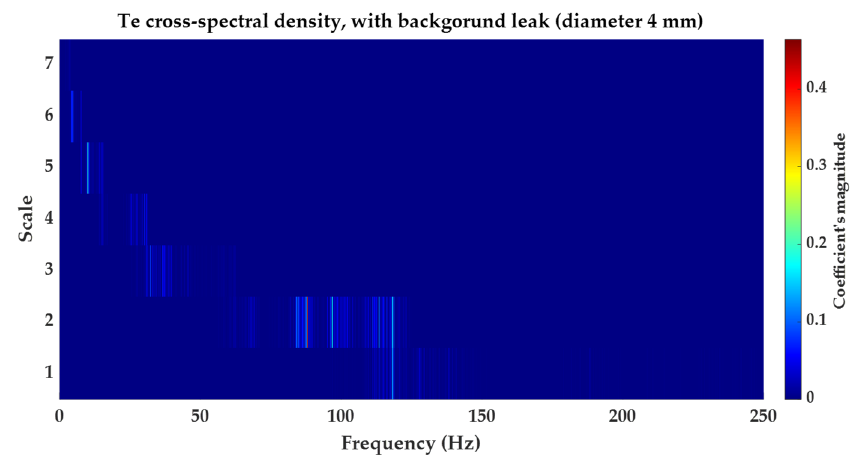
Figure 19. 𝒯 (cid:3032) cross-spectral density, with background leak ( 4 mm in diameter) and flow rate Figure 19. T e cross-spectral density, with background leak (4 mm in diameter) and flow rate 125.0 mL/s . 125.0 mL/s.